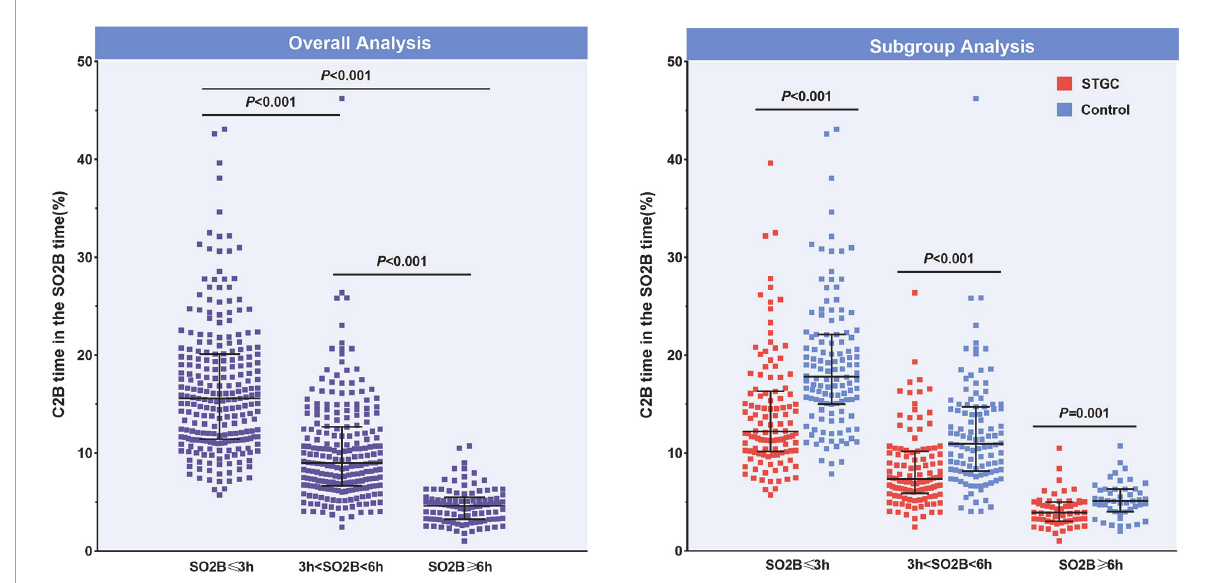
FIGURE5 Proportions of C2B time in the SO2B time. The proportion of C2B time in the SO2B time was significantly different for patients with SO2B time ≤ 3, 3–6, and ≥ 6 h (15.6% vs. 9.0% vs. 4.6%, p < 0.001, respectively). In subgroup analysis, the proportion was also significant different between the STGC group and the control group ( p < 0.001, respectively). C2B, catheterization laboratory door-to-balloon; SO2B, symptom to balloon; STGC, single transradial guiding